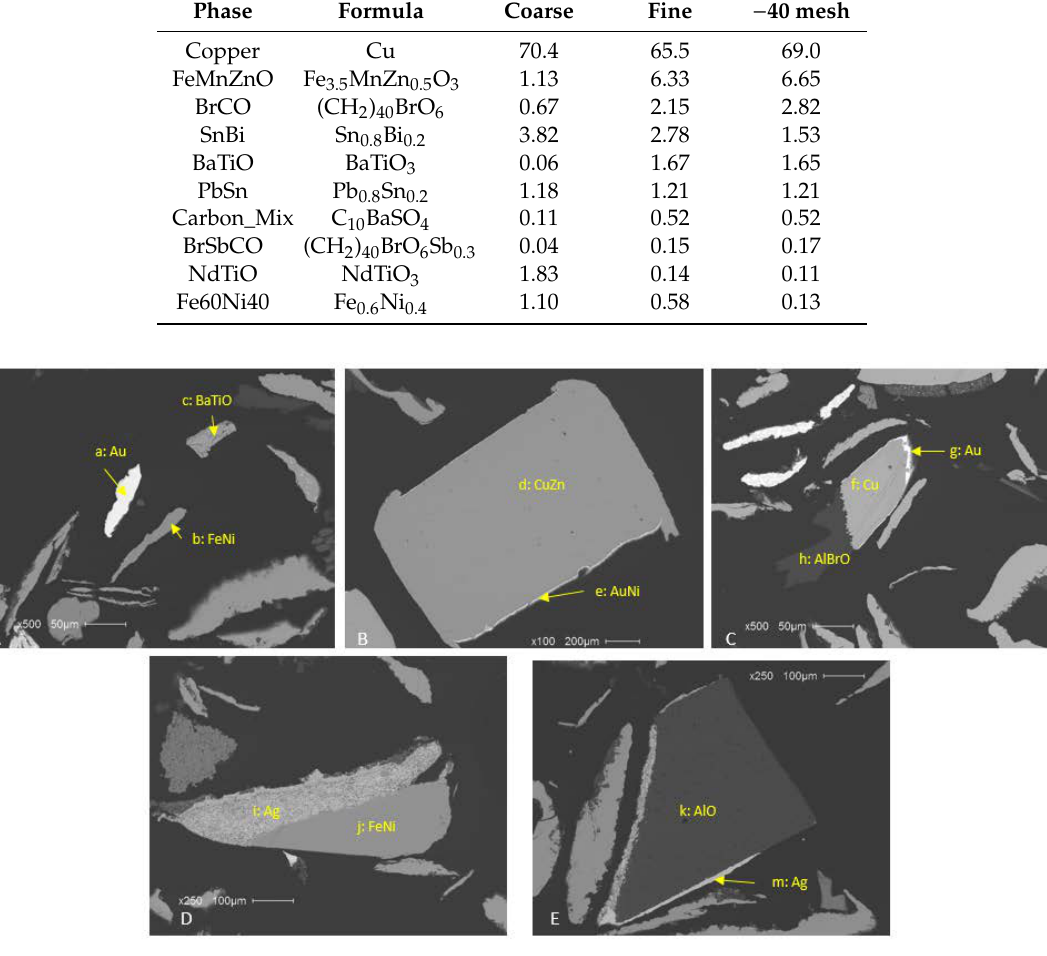
Figure 3. Image of gold and silver associations in shredded printed circuit boards ( A : isolated gold particles; B : gold-nickel alloy coatings; C : Au coatings; D : Ag with FeNi; E : Ag with aluminum oxide).